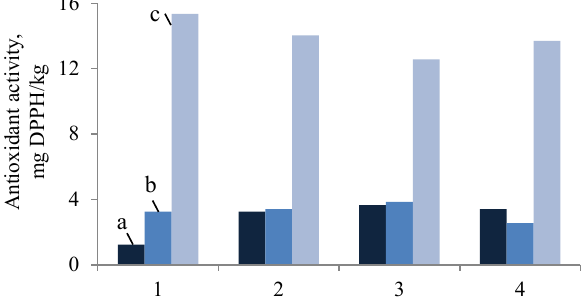
Figure 1 Antioxidant activity of callus (a), suspension (b), and root (c) extracts obtained from Eleutherococcus senticosus (1), Codonopsis pilosula (2), Platanthera bifolia (3), and Saposhnikovia divaricate